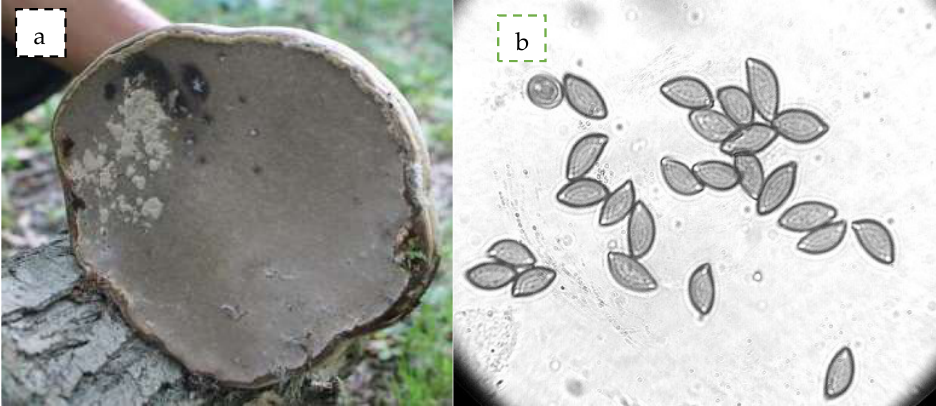
Figure 1. Photographs of brown rot basidiomycetes— F. fomentarius , ( a ) under view showing pores ( b ) basidiospores at 100 ×